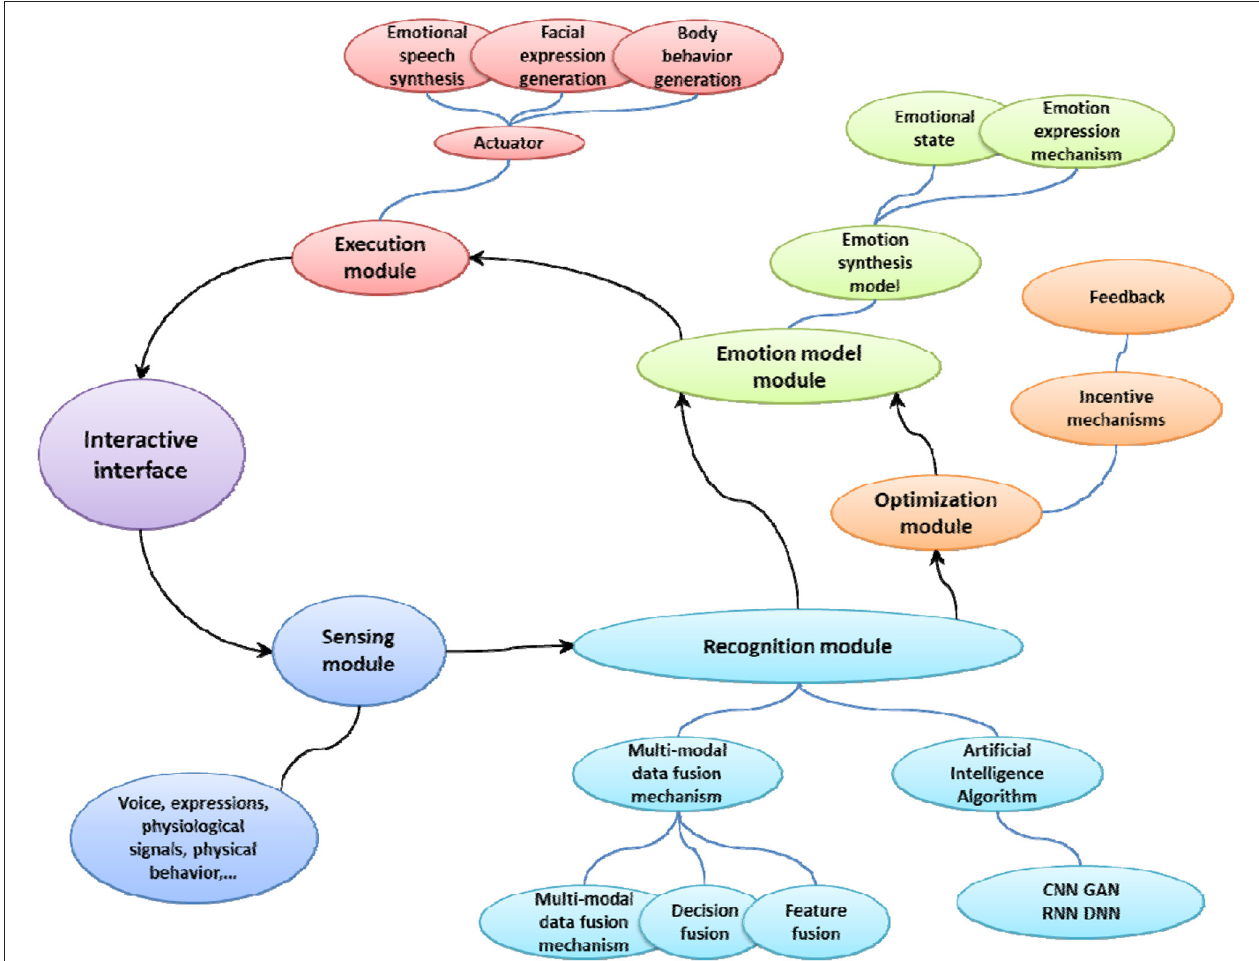
FIGURE 2 | Interaction design framework based on emotion